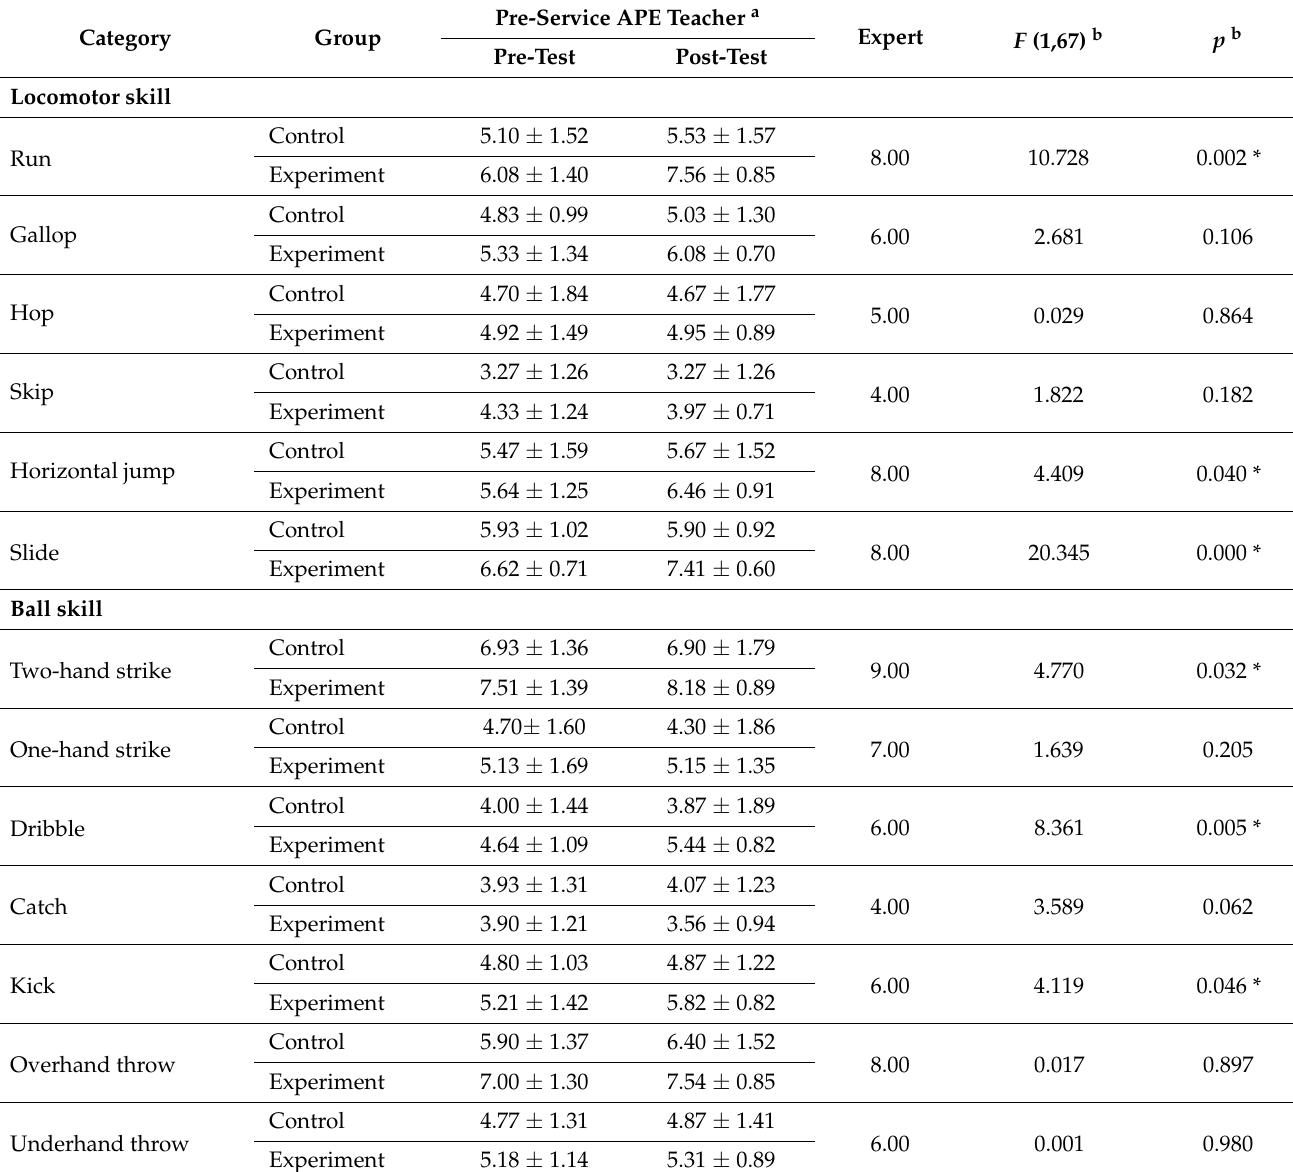
Table 3. Descriptive and statistical results of the TGMD-3 skill score comparison between pre-service APE teachers and